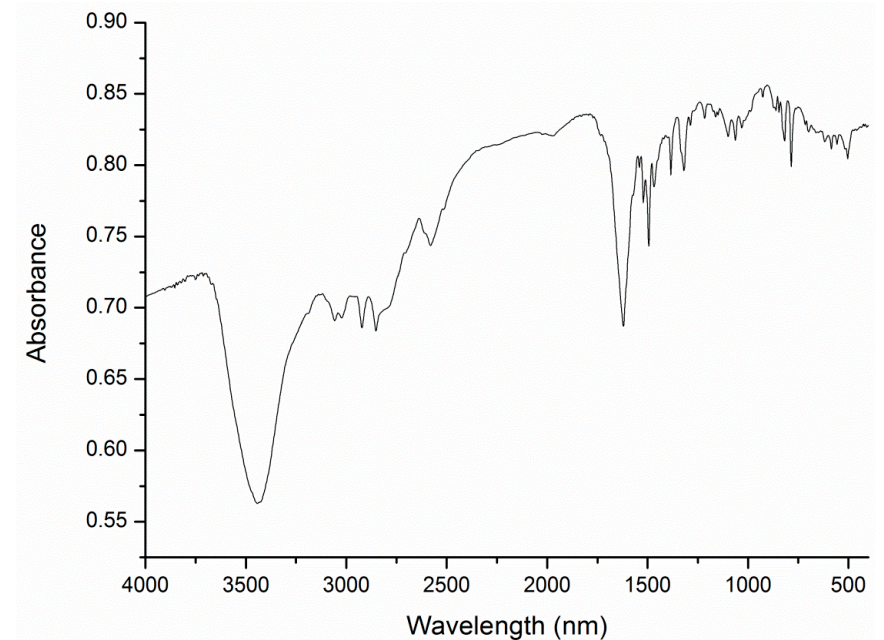
Figure A3. IR spectrum of ( L4